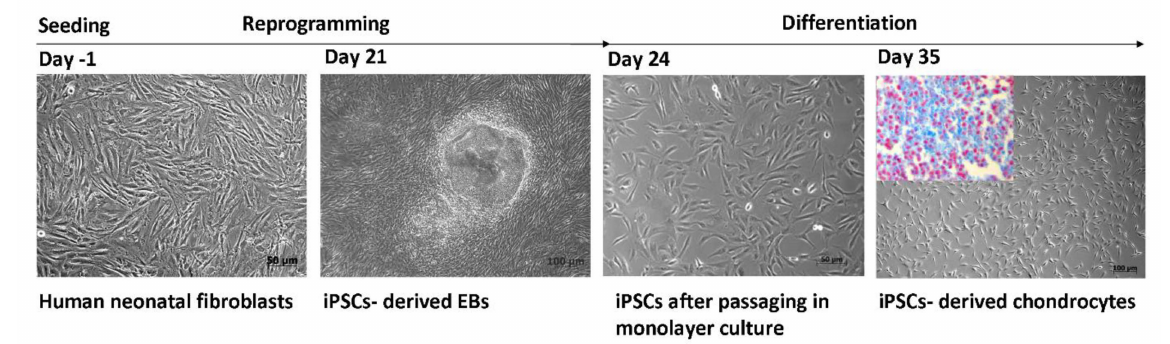
Figure 1. The generation of induced pluripotent stem cell (iPSC)-derived chondrocytes through the embryoid bodies (EBs)